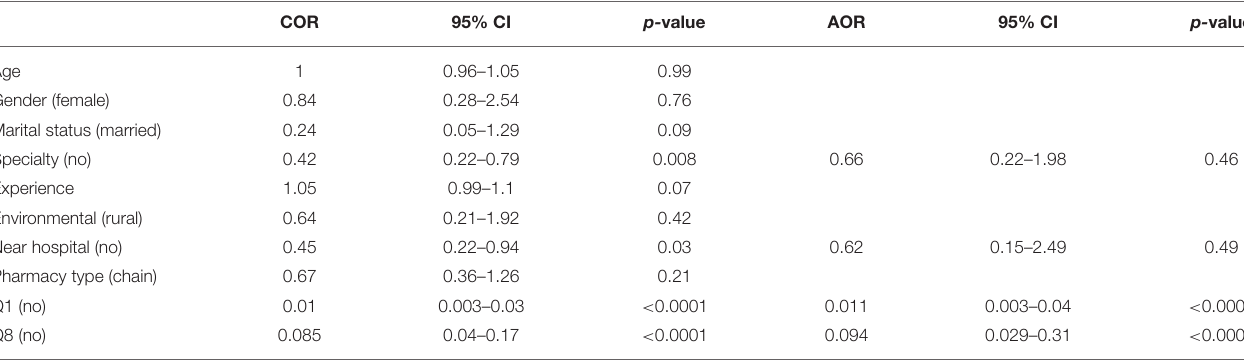
TABLE 5 | Logistic regression analysis of significant factors associated with the willingness of administering vaccination in the community pharmacies from Romania. COR 95% CI p- value